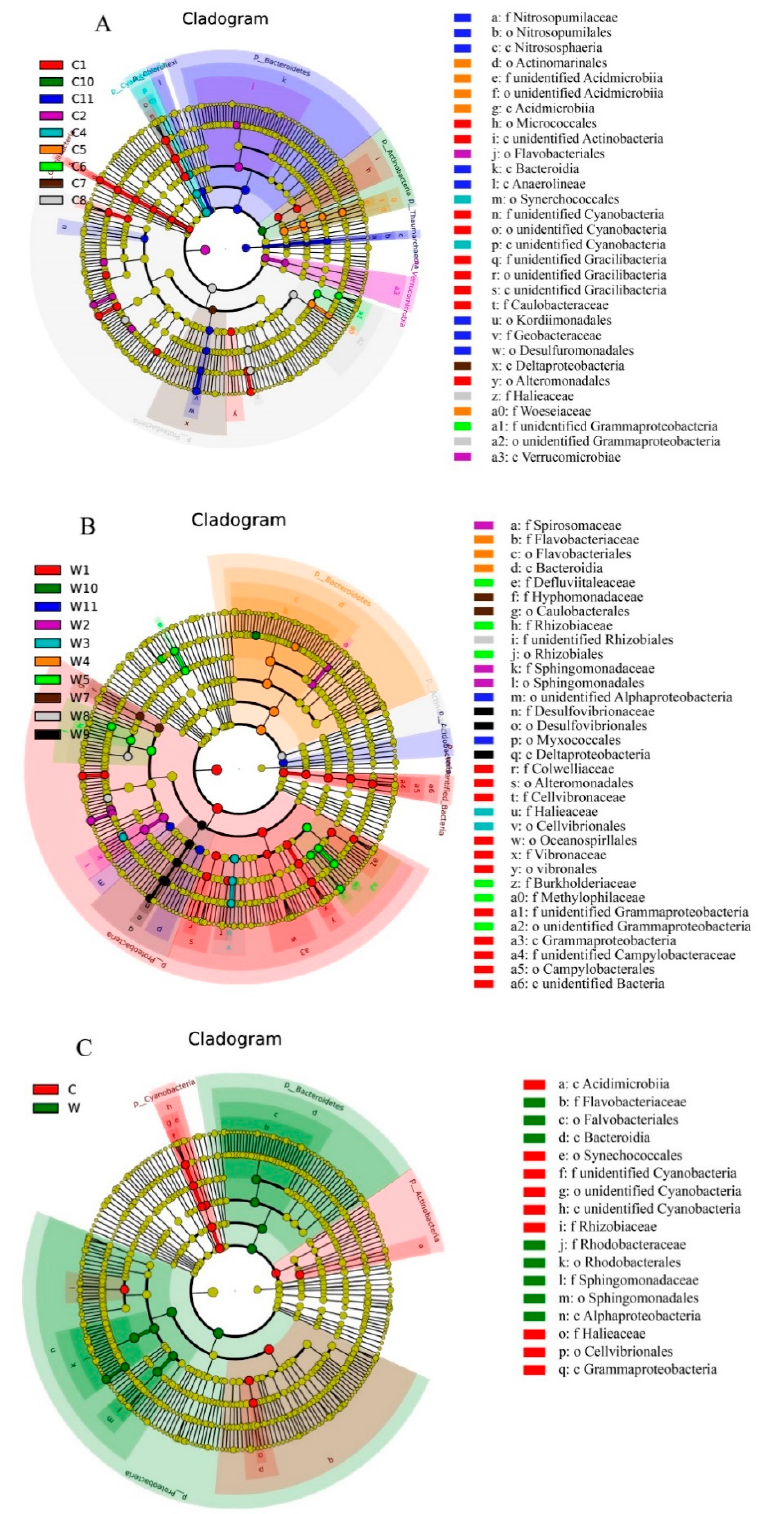
Figure 4. Taxonomic cladograms of the least discriminant analysis (LDA) effect size show significant microbial taxa that were discriminant within concrete group ( A ), within wooden group ( B ) and between concrete and wooden groups ( C ). Significantly discriminant taxon nodes are colored. Yellow nodes represent non-significant differences between groups. Diameter of each node represents the relative abundance of each